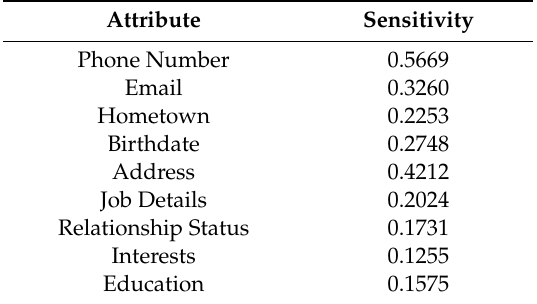
Table 3. Attribute